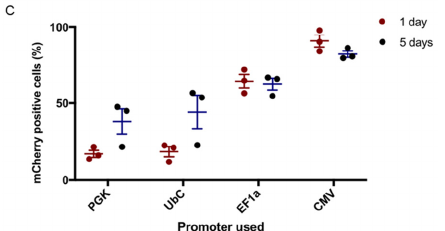
Figure 6. Lentiviral transduction of mCherry reporter gene under the control of several promoters. iHMuSCs control 1—D52, control 2—E4 and control 3—A42 were transduced with lentiviruses containing mCherry under the control of PGK, UbC, EF1 or CMV promoters or with an empty lentivirus. ( A , B ) Immunostaining was performed 1 ( A ) and 7 ( B ) days after transduction for the detection of desmin (green). mCherry is red. Nuclei are labelled with Hoechst (blue). Bars = 100 µ m. ( C ) Quantification of the expression of mCherry in iHMuSCs using flow cytometry 1 and 5 days after the lentiviral transduction. Results are given in percentage of mCherry positive cells and were done on the 3 di ff